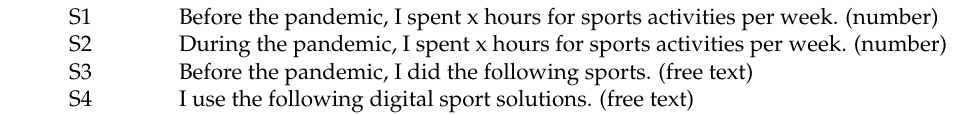
Table 1. Questions regarding the sample.